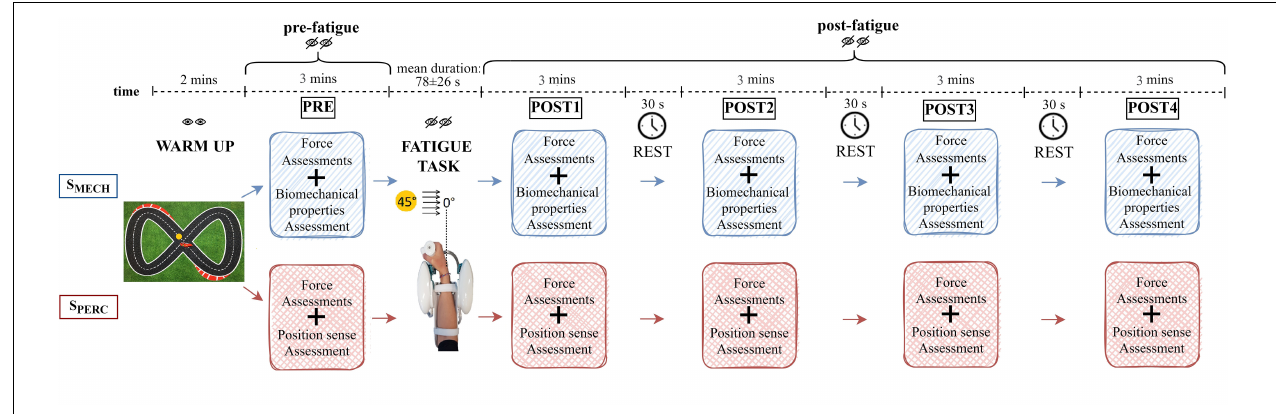
FIGURE 1 | Schematic representation of the experimental protocol. Both sessions (S MECH and S PERC ) were performed by each subject on two different days in random order. Both the warm-up and the fatigue task were repeated during both